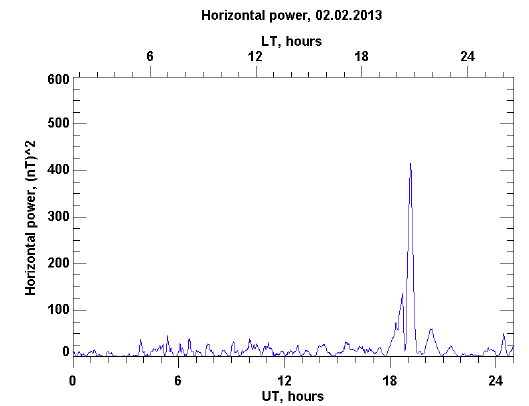
Fig.6. Horizontal power of the magnetic field perturbations on 02 February 2013 at Panagjurishte. The obtained maximum at about 19:10 UT corresponds to the substorm, observed in the auroral zone, on the IMAGE longitudinal chain PPN-NAL.